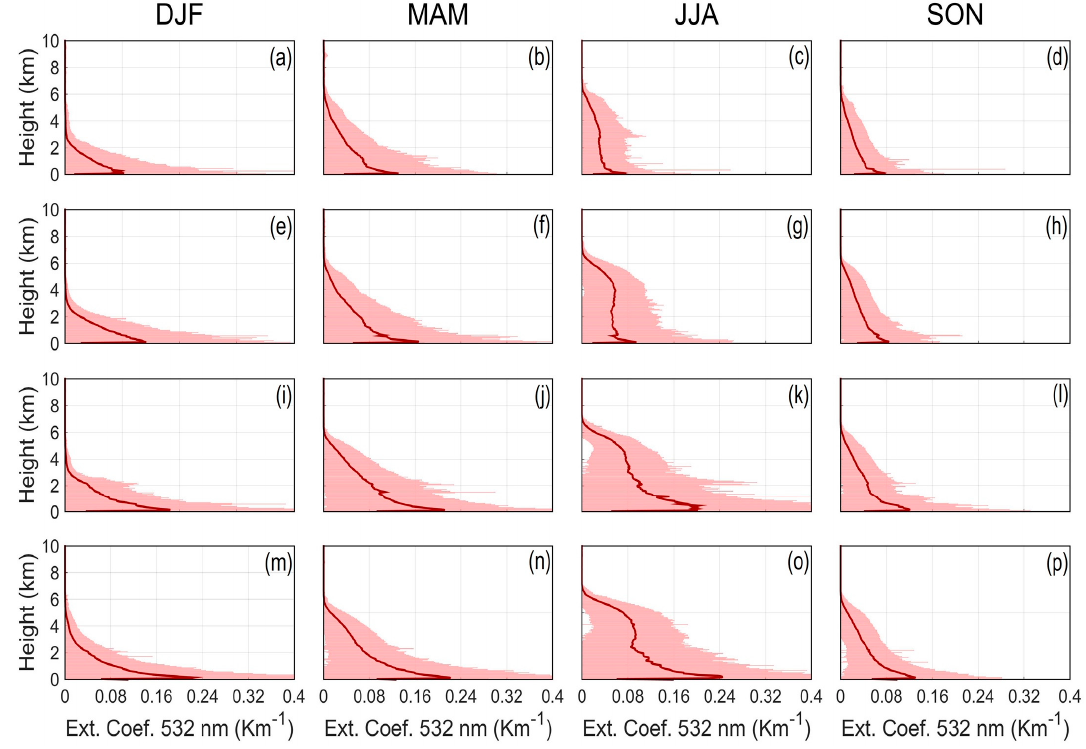
Figure 9. CALIPSO seasonal mean pure dust climatological extinction coefficient profiles at 532 nm (in km − 1 ) for the regions NRS ( a – d ), NCRS ( e – h ), SCRS ( i – l ), SRS ( m – p ), and for the three month averages: December to February (DJF), from March to May (MAM), from June to August (JJA), and from September to November (SON), for the period 01/2007–12/2015.